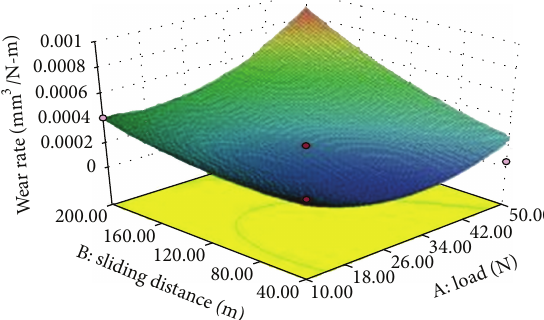
Figure 6: Variation of specific wear rate of Al-Gr composites with varying load and sliding distance.